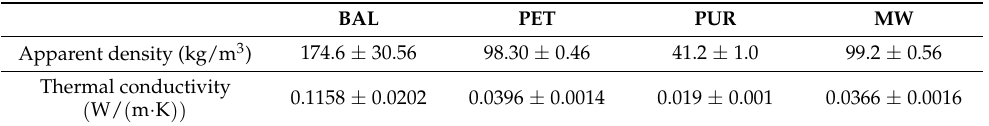
Table 5. Results of thermal conductivity (W/(m · K) of the core materials at 10 ◦ C (the mean and the standard deviation of three test specimens).